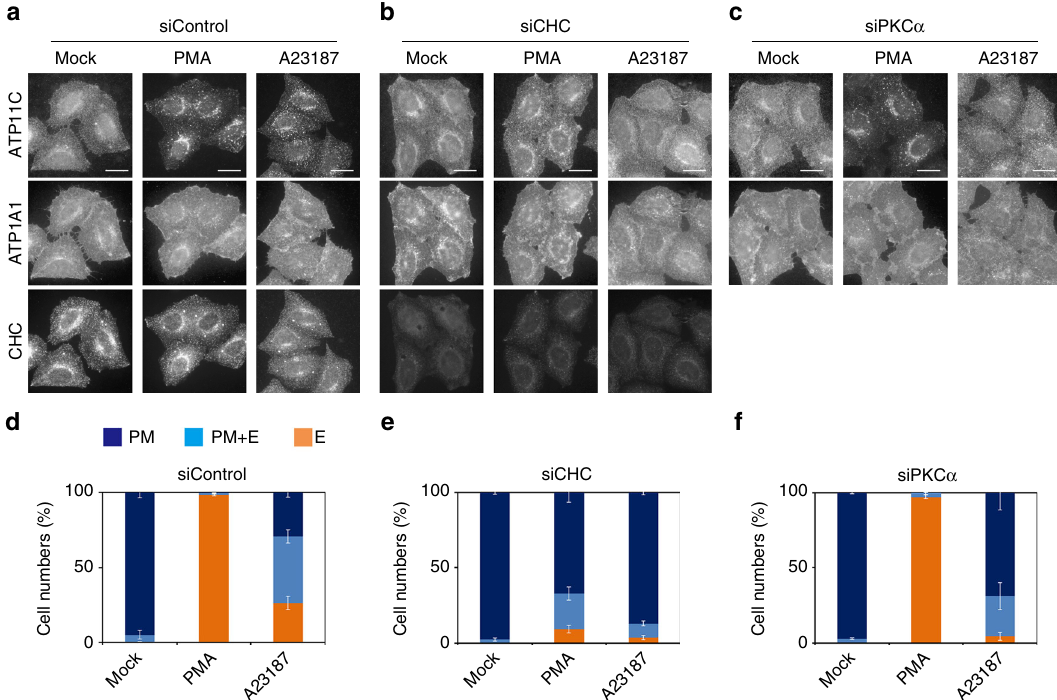
Fig. 9 ATP11C is downregulated by clathrin-mediated endocytosis upon PKC activation. HeLa cells stably expressing ATP11C-HA were transfected with non-targeting siRNA (siControl) ( a , d ) or siRNAs against clathrin heavy chain (CHC) ( b , e ) or PKC α ( c , f ). (see Supplementary Fig. 4). Each siRNA-treated sample was treated with vehicle alone (Mock), 400 nM PMA (PMA), or 1 μ M A23187 in the presence of CaCl 2 (A23187) for 15 min, followed by fi xation. The fi xed cells were permeabilized and incubated with anti-HA, anti-ATP1A1, and anti-CHC antibodies, followed by Cy3-conjugated anti-rat, Alexa Fluor 647-conjugated anti-rabbit, and Alexa Fluor 488-conjugated anti-mouse secondary antibodies. Scale bars, 20 μ m. d – f The cells in which ATP11C localized to the plasma membrane (PM), to the plasma membrane and endosomes (PM + E), or to endosomes (E) were counted; counts were normalized against the total number of counted cells. In each sample, 643 – 783 cells were counted. Graphs display averages ± SD from three independent